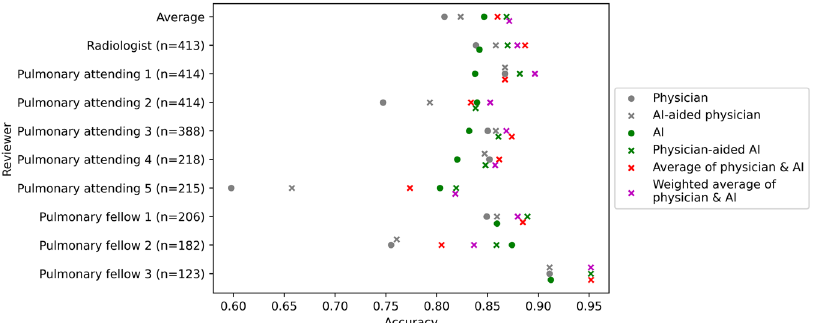
Fig. 4 The accuracy of individual physicians, along with the performance of AI and four combinatory strategies when assessed on the same subset as physicians. Numbers in parentheses indicate the number of chest X-rays that each physician